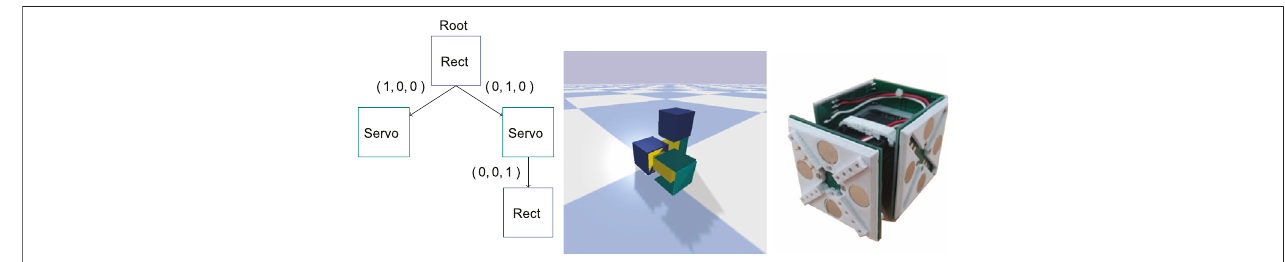
FIGURE 1 | On the left the tree representation of the encoding is shown. The nodes in the graph represent modules and edges represent connections between modules. Each module has a certain number of possible connections where the triple ( X , Y , Z ) denotes where the connection is, relative to the parent, in 3D. Note that modules have additional properties, such as rotation , which is not shown in this illustration. In the middle the simulated modular robot corresponding to the encoding is shown in the REM framework. In the center is the root node, illustrated as a blue box. The root node has two direct connections, the two servo modules: one